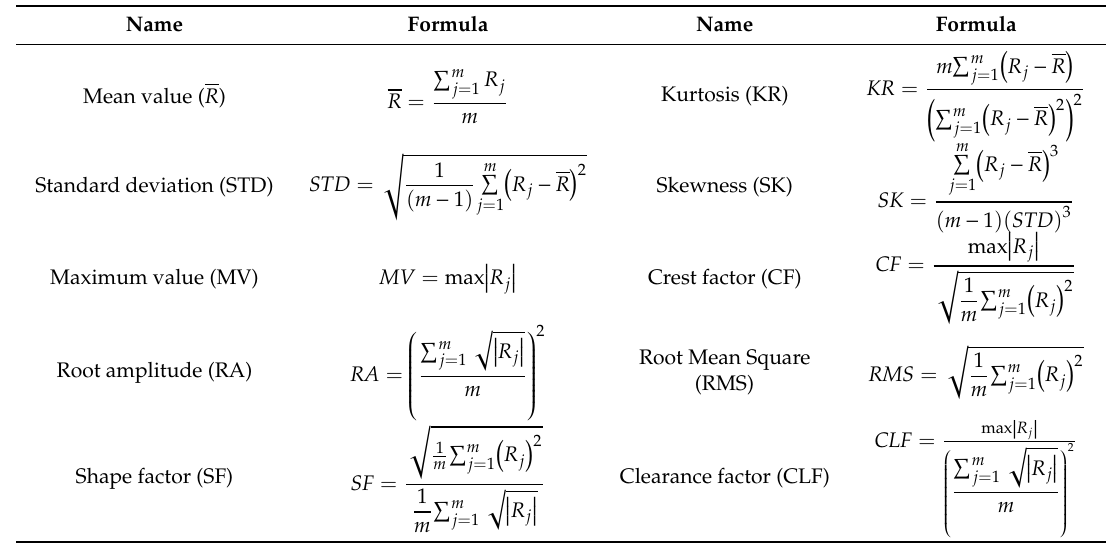
Table A1. Time domain features extraction.